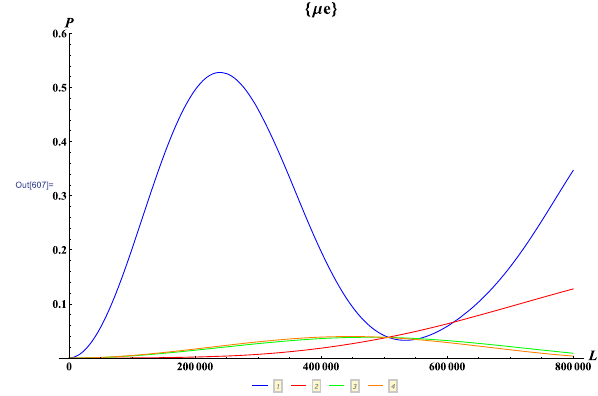
Fig. 10 Comparison of the P ν μ ,ν oscillation probability, as a func- e tion of the baseline L, for neutrino energy E = 1TeV, for a “standard theory”, preserving Lorentz invariance (orange curve) and for different versions of models including LIV, with parameters equal, respectively, to δ f 32 = δ f 21 = 4 . 5 × 10 − 27 (blue), δ f 32 = δ f 21 = 4 . 5 × 10 − 28 (red) and δ f 32 = δ f 21 = 4 . 5 × 10 − 29 (green curve)